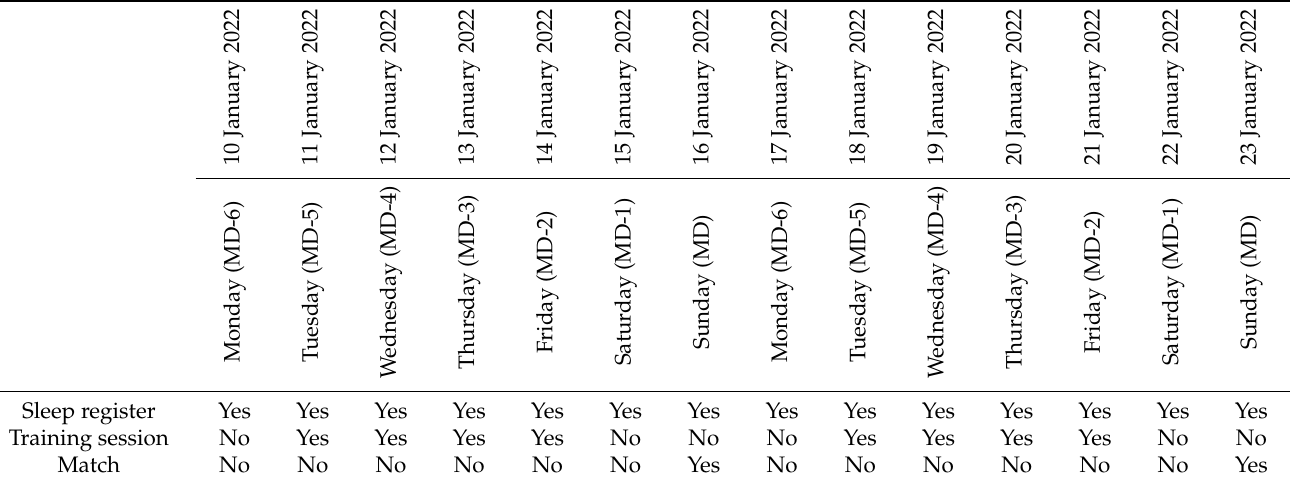
Table 1. Timeline of the